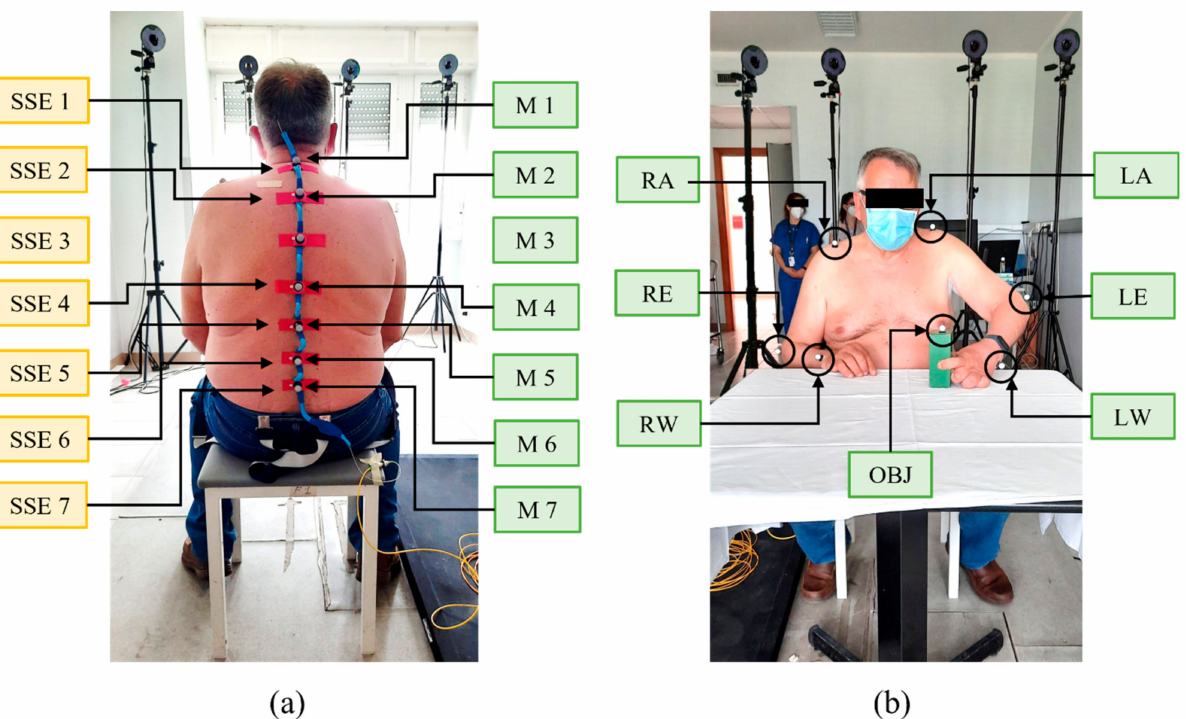
Figure 5. Soft sensing elements’ and markers’ positioning on a volunteer. In ( a ) the placement of the seven sensors (yellow box texts) and markers (green box texts) on the back of the volunteer is shown. In ( b ) the placement of the seven markers (green box texts) upon the object and the volunteer’s acromia, elbows and wrists is